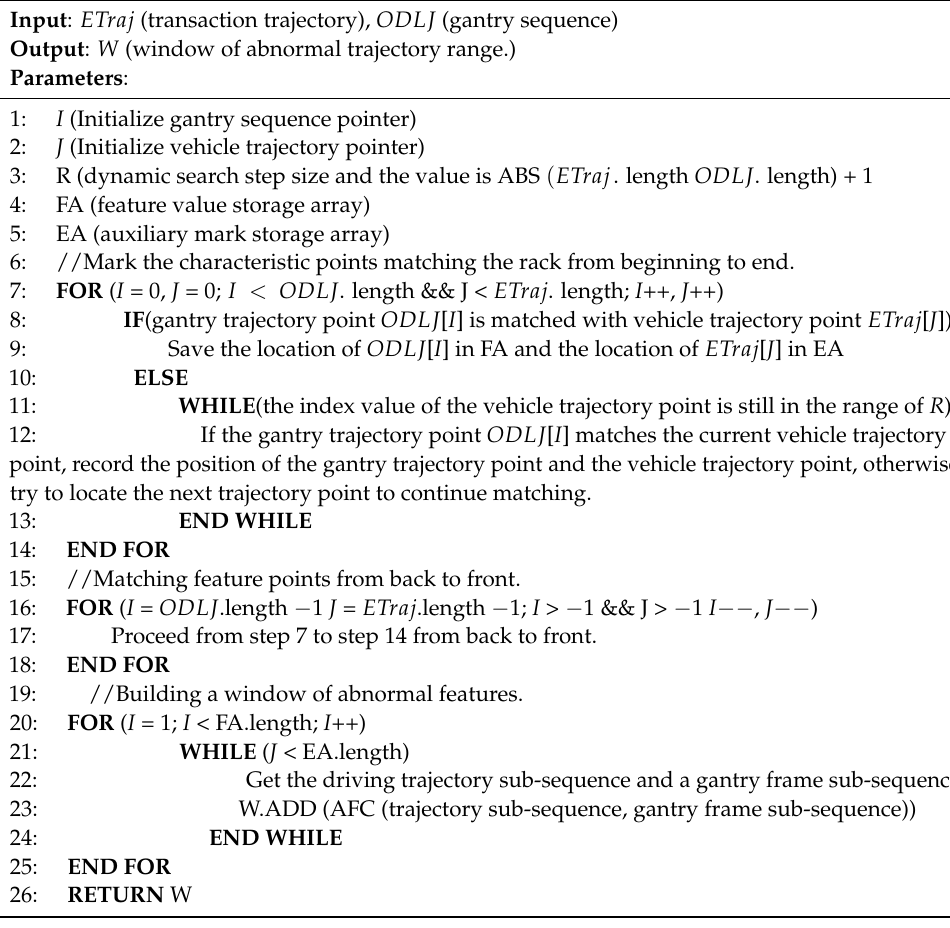
Algorithm 1 for realizing matching feature points P and establishing search window W of abnormal trajectory range is as follows. Algorithm 1. Algorithm for establishing anomalous trajectory range retrieval